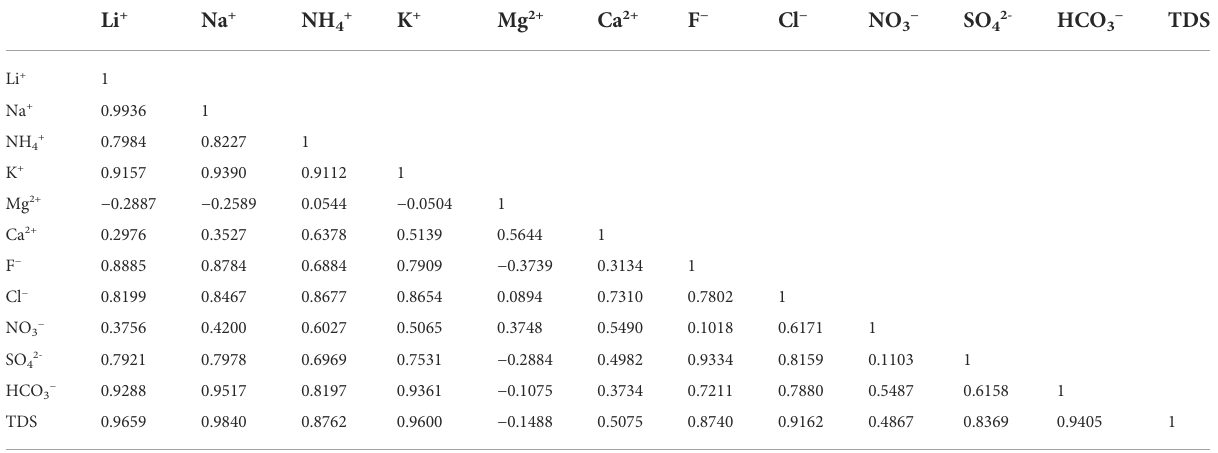
TABLE 3 Correlation coef fi cient (r) of chemical components of the water